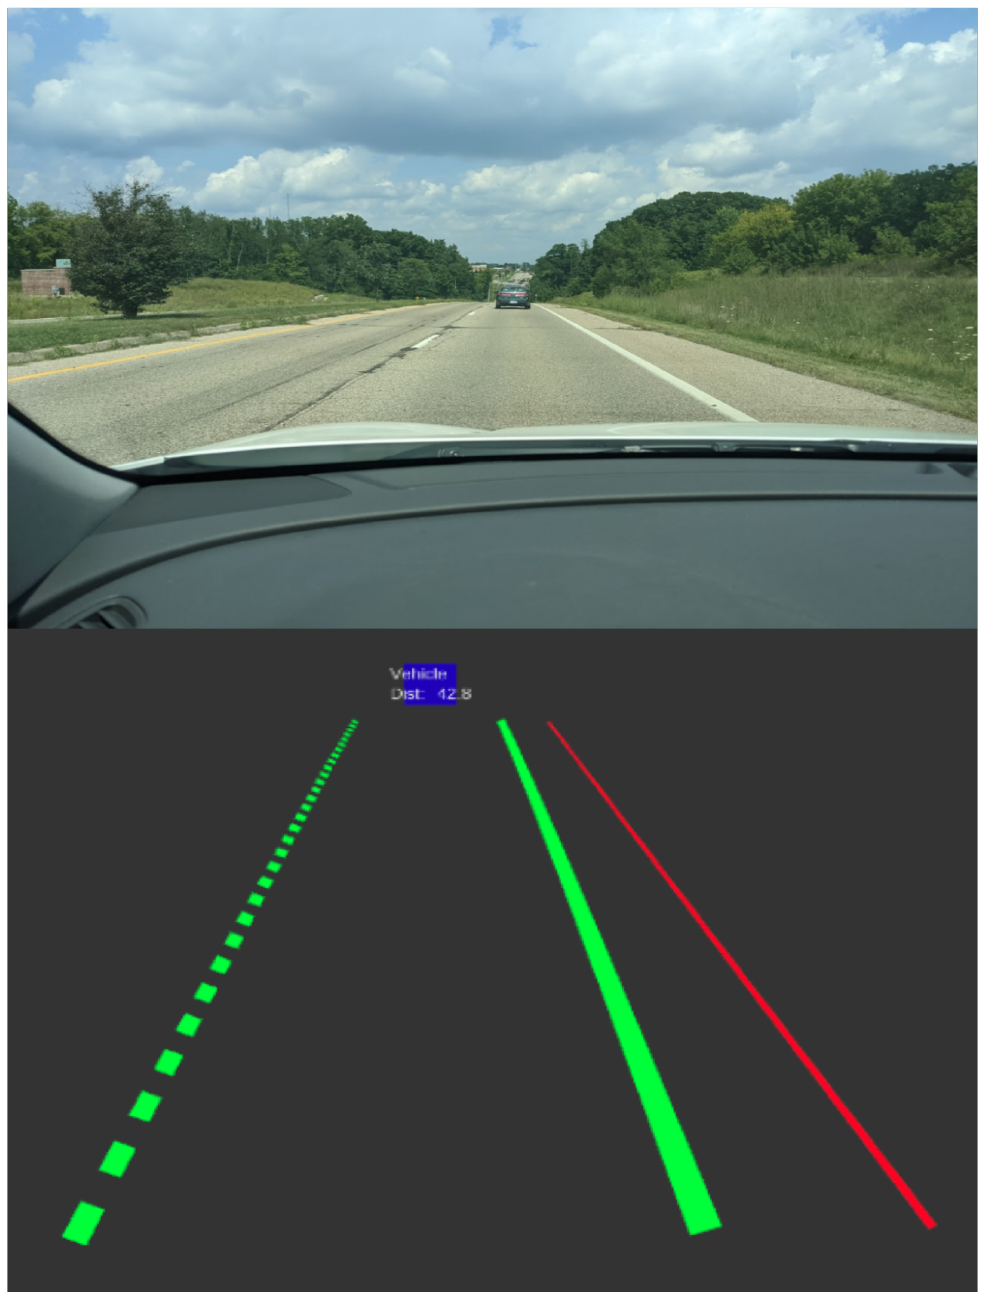
Figure 17. MobilEye lane line, road edge, and object detection visualization using Rviz with